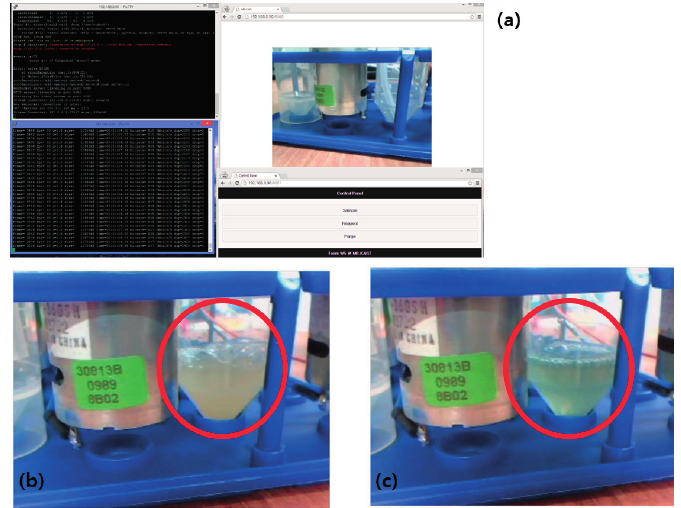
Figure 6. Operation of the sensor node. ( a ) Screenshot of operating sensor node. Console shows video stream and data request from user. Web pages show live image served to the end user and motor control buttons; ( b ) Streamed image of reaction chamber (red circled region) before reaction occurs; ( c ) Image of reaction chamber after reagent and E. coli incubated. Color in red circled region changes compared to Figure 6b.